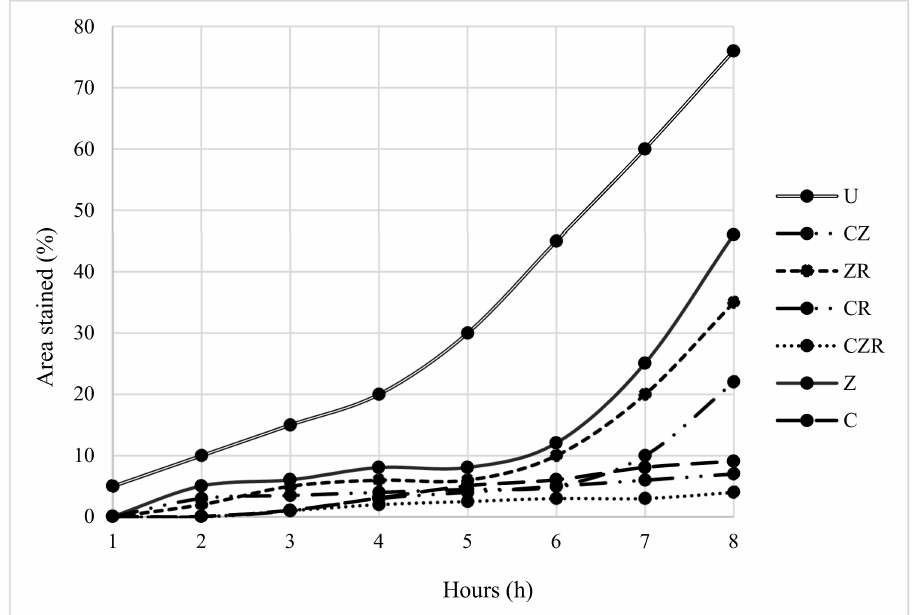
Figure 2. Grease resistance of the uncoated (U), chitosan and zein coated (CZ), blend zein and rosemary oil coated (ZR), blend chitosan and rosemary oil coated (CR), chitosan and blend zein and rosemary oil coated (CZR), pure chitosan in one layer coated (C) and the pure zein in one layer coated (Z)